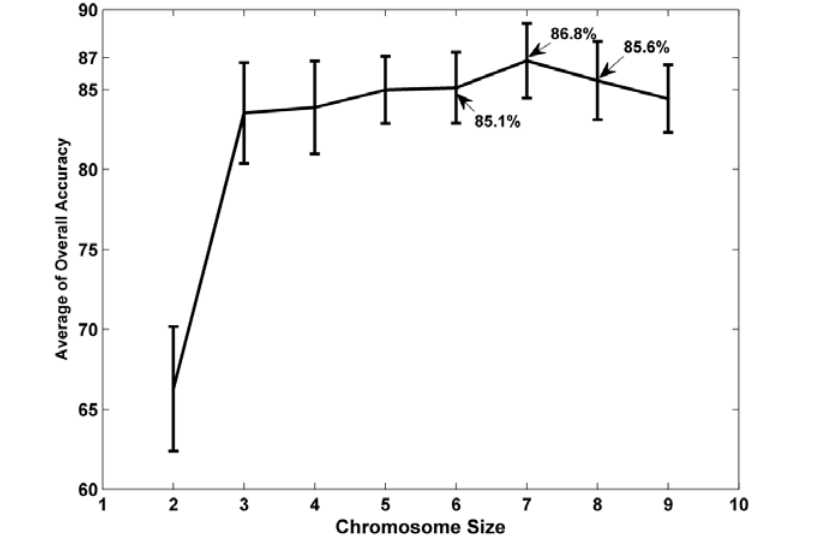
Figure 4. A comparison between the averaged overall accuracies plus the standard deviation bars of eight different chromosome sizes varied from 2 to 9 spectral channels selected by the genetic search